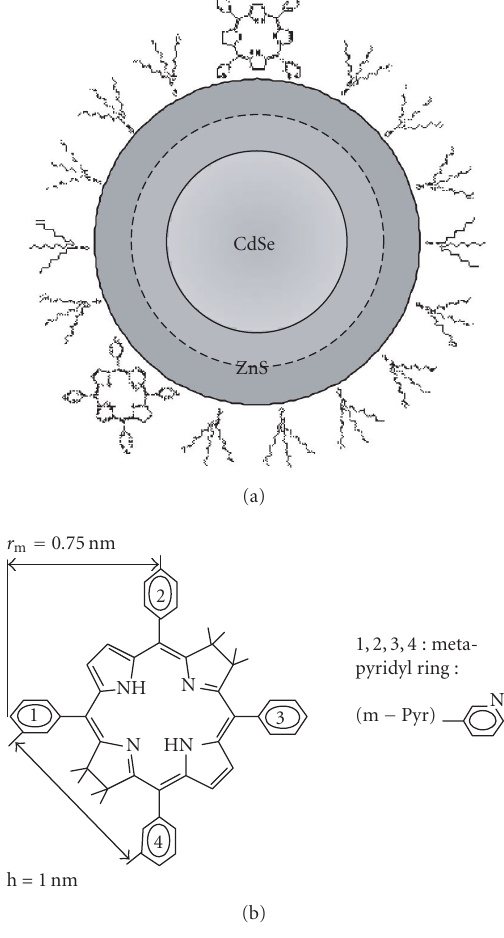
Scheme 1: Model of a YQD CdSe / ZnS nanoassembly with TOPO molecules and two porphyrins on the surface (a). Structure of tetra- hydroporphyrin (THP) with a scheme for m-pyridyl substitution